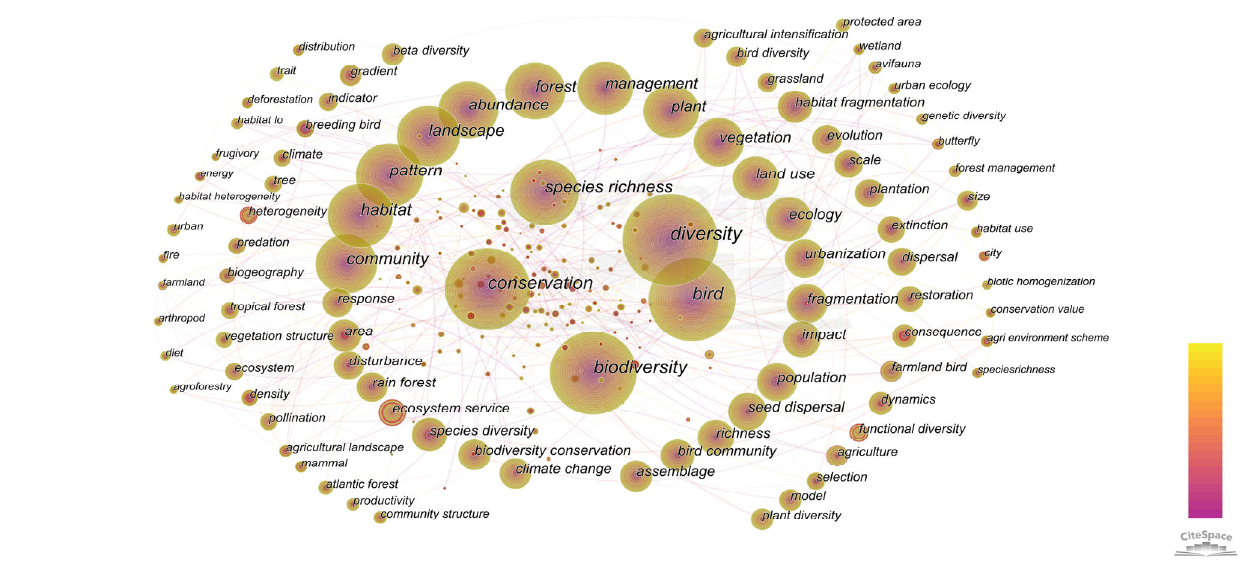
Figure 4. Keyword co ‐ occurrence map. Table 4. The 20 keywords with the highest total number and concentration of research papers pub ‐ lished in the study.